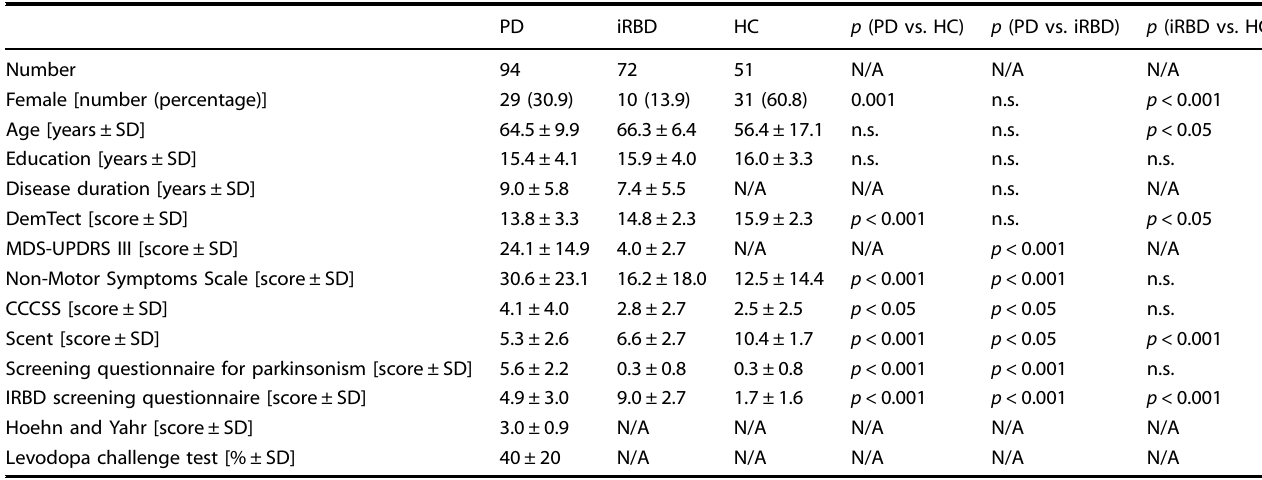
Fig. 1 Schematic fi gure of the sFIDA assay principle. The glass surface of a microtiter plate is coated with a capture antibody (Syn211) against amino acid residues 121 – 125 of α -synuclein. The capture antibody binds both α -synuclein monomers and aggregates in the sample. The detection antibody (Syn211), a 1:1 mixture of this antibody labeled with fl uorescent dye CF633 or CF488A, can only detect aggregates since it is directed against the same epitope as the capture antibody. The epitope on the monomer bound to the capture antibody is masked by the capture antibody and can, thus, not be bound by the detection antibody. The microtiter plate wells are imaged by two-channel confocal fl uorescence microscopy to detect single particles. Only particles decorated with at least two different detection antibodies (colocalized signal) contribute to the sFIDA readout signal. The image was created with BioRender.com. Table 1. Demographic and clinical information on patients and controls that donated stool